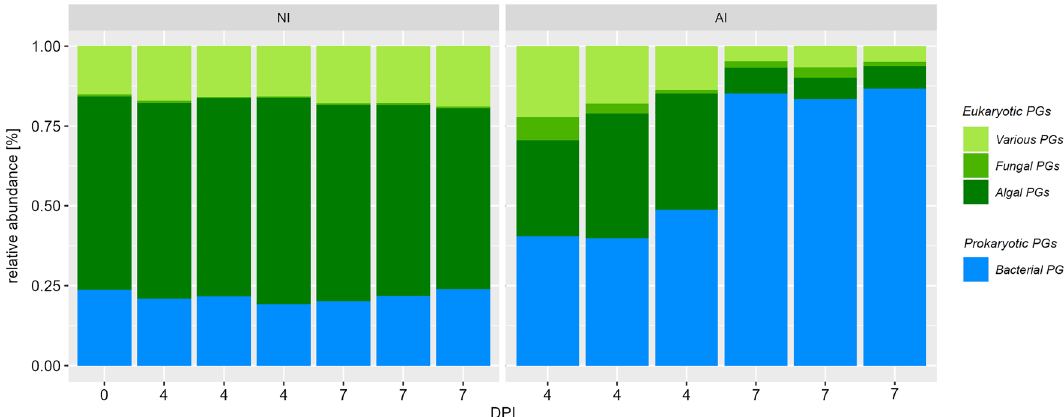
Figure 2. Composition of protein groups (PGs) according to taxonomic affiliation to bacterial (blue) and eukaryotic (algae = dark green, fungi = green, various = light green) PGs in non-infected (NI) and aphelid- infected (AI) S. vacuolatus cultures over days post inoculation (DPI). Mean of three independent replicates per treatment and incubation time are indicated (mean of n = 3 ±